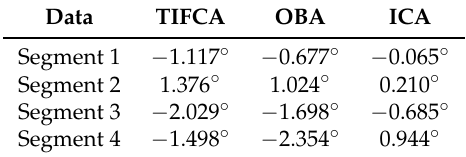
Table 6. The final heading angle error of four segments.